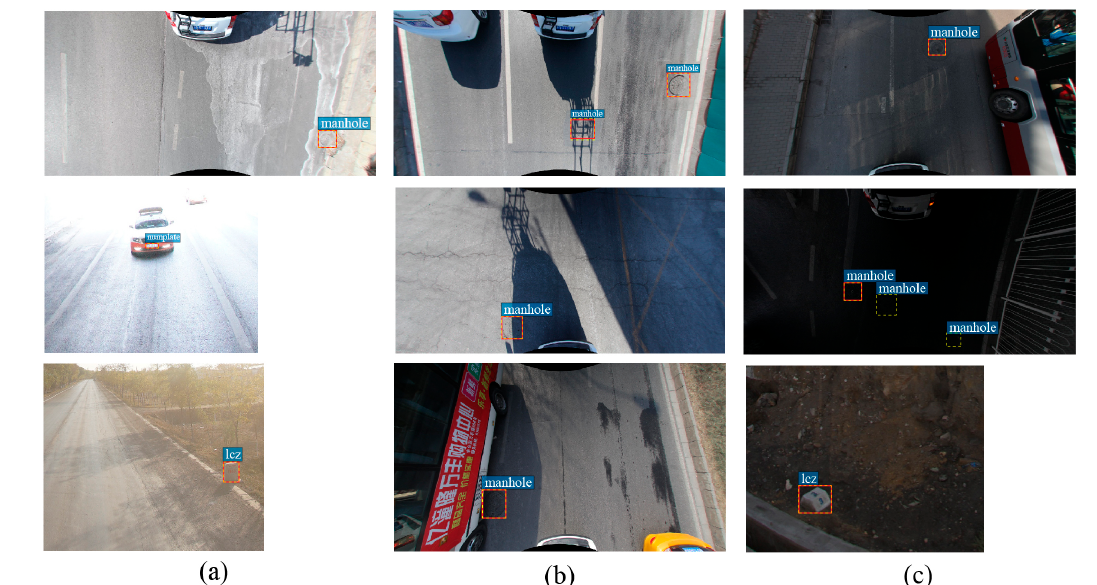
Figure 9. Performance under different lighting conditions: ( a ) objects in light condition; ( b ) objects under shade; ( c ) objects in dark condition. Red is the predicted bounding box and dashed yellow is the ground reference bounding box.